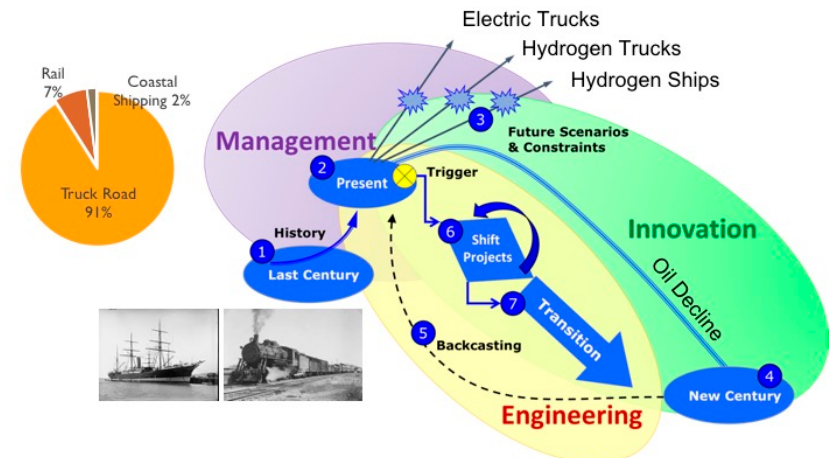
Figure A1. Interdisciplinary Transition, Innovation, Management and Engineering (InTIME) methodology with the project (4) New Century path-break concept generation.